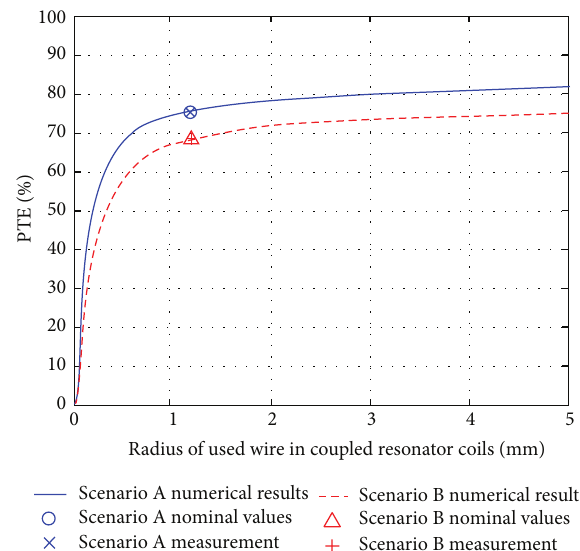
Figure 5: PTE versus radius of the used wire in coupled resonator coils for two different DCR configuration